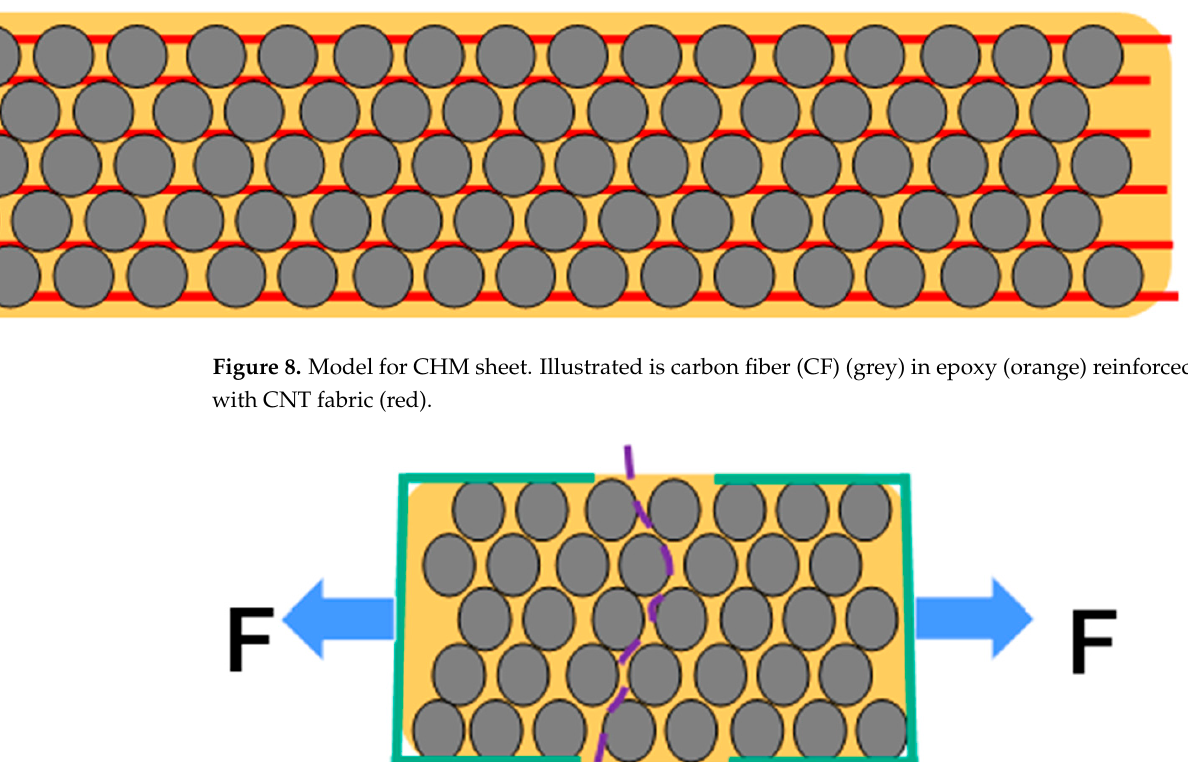
Figure 9. Illustration of a conventional unidirectional ply. The epoxy cracks at a low load (purple dash line).